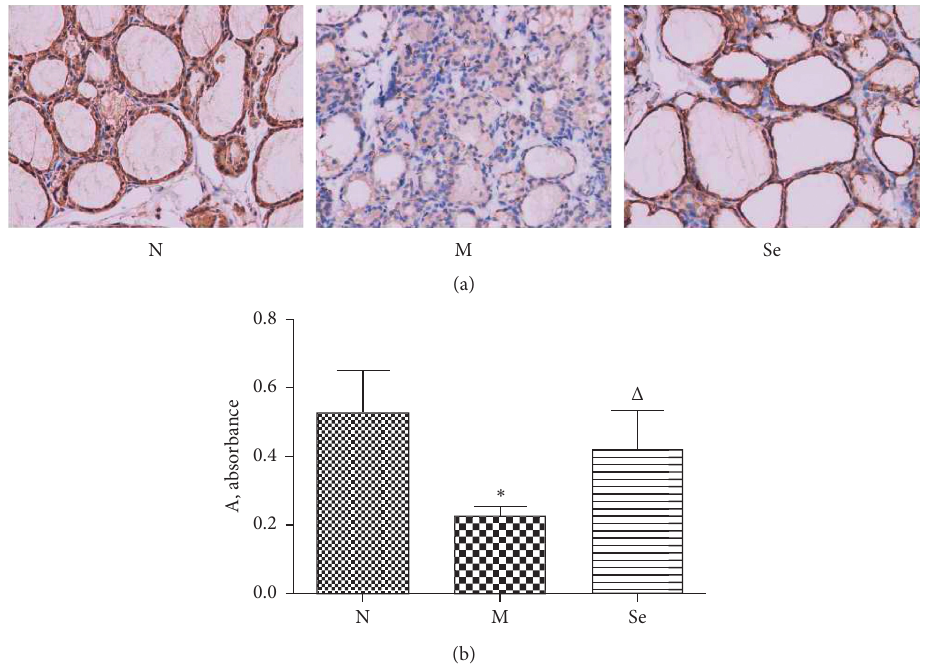
Figure 4: (a) Representative histographs of IL-10-stained thyroid sections. (b) Semiquantitative analysis of IL-10 expression in the thyroid, by absorbance evaluation. ∗ P < 0 . 05 compared to the N group. △ P < 0 . 05 compared to the M group (at 400 ×